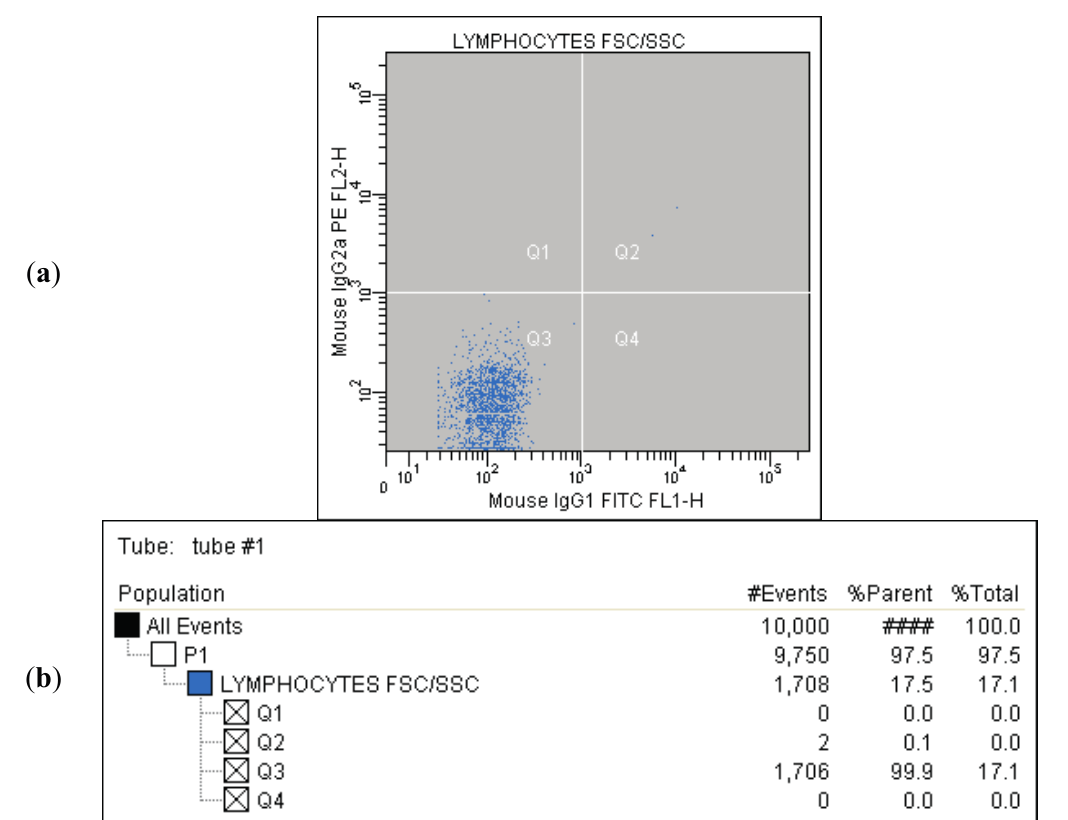
Figure 1. Gated lymphocyte sub-population based on SSC (Side-Scattered light) vs. FSC (Forward-Scattered light) measurement.